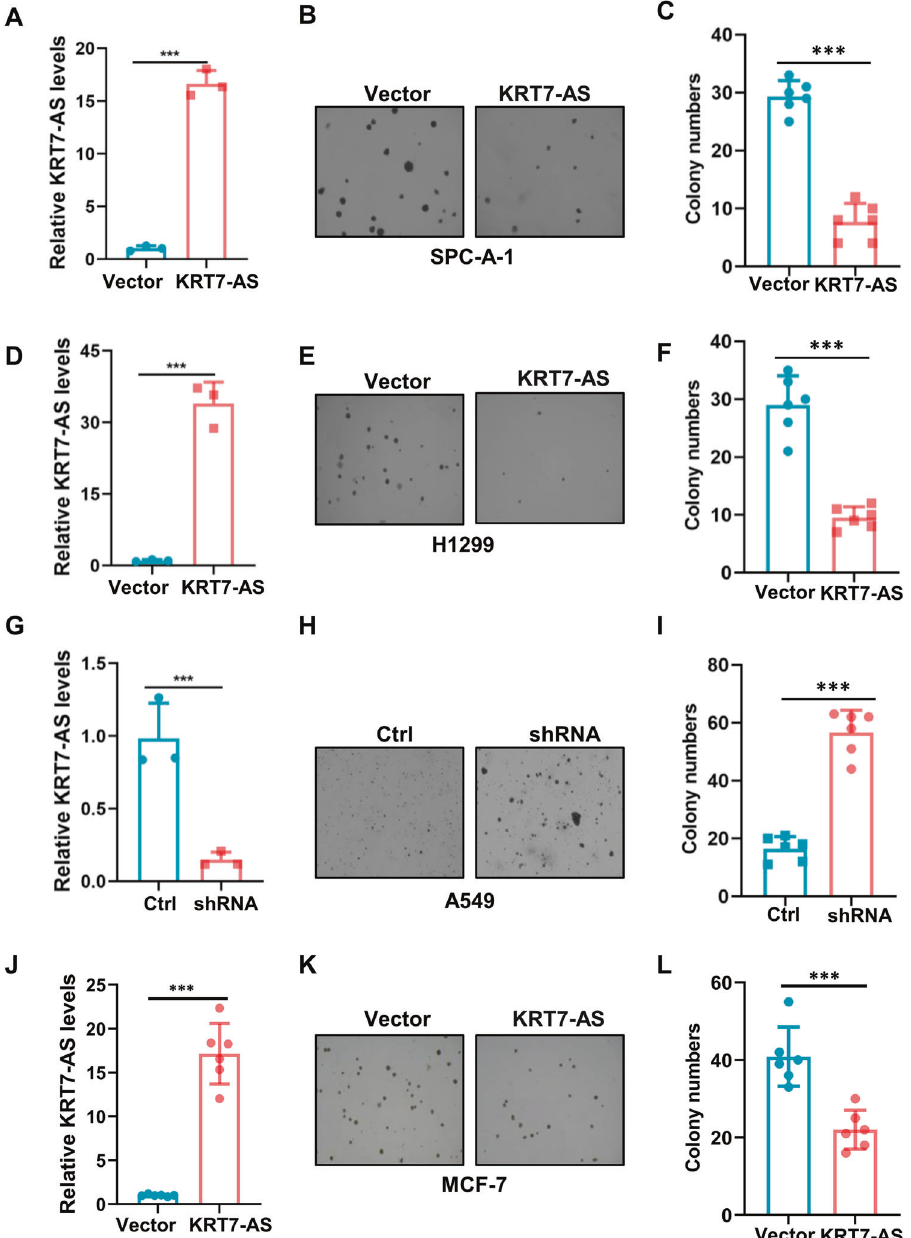
Fig. 2 KRT7-AS inhibits lung and breast cancer cell colony formation ability in vitro. KRT7-AS expression levels in lung cancer SPC-A-1 cells were detected by real time qPCR ( A ). Colonies of KRT7-AS-overexpressed SPC-A-1 cells were imaged and quanti fi ed ( B , C ). The expression levels of KRT7-AS in H1299 were measured by real time qPCR ( D ). The colony formation ability of H1299 cells was accessed ( E , F ). The KRT7-AS expression levels in lung cancer A549 cells were detected by real time qPCR ( G ). Colonies of KRT7-AS-silenced A549 cells were imaged and quanti fi ed ( H , I ). The colony formation ability of breast cancer MCF-7 cells overexpressed KRT7-AS or vector control was accessed ( J – L ). Data are shown as mean ± SD of three independent replicates. * P < 0.05, ** P < 0.01, *** P <